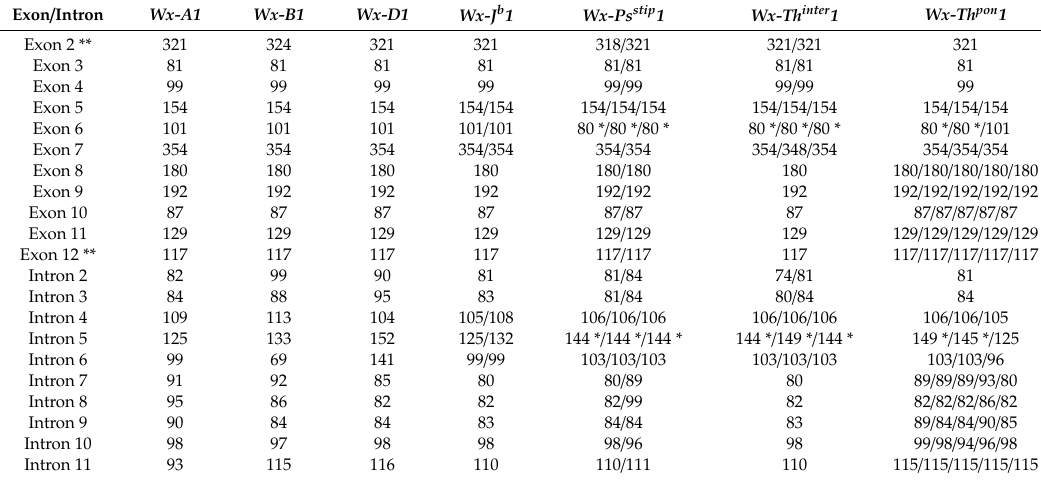
Table 3. Exon and intron sizes of the Wx sequences in bread wheat (Wx-A1, Wx-B1, Wx-D1)